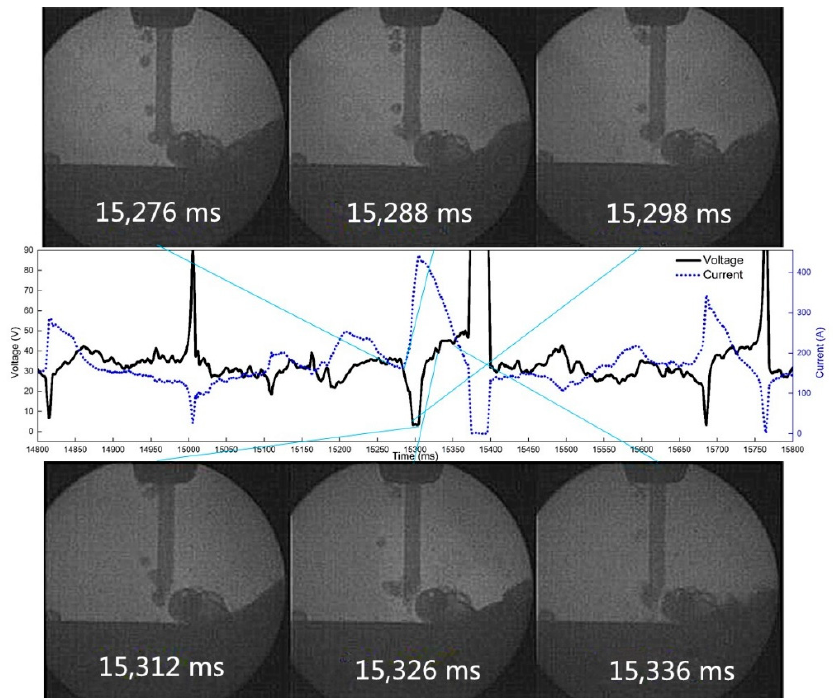
Figure 5. Droplet transition process at 60 Hz and 0.5 mm withdrawal quantity.